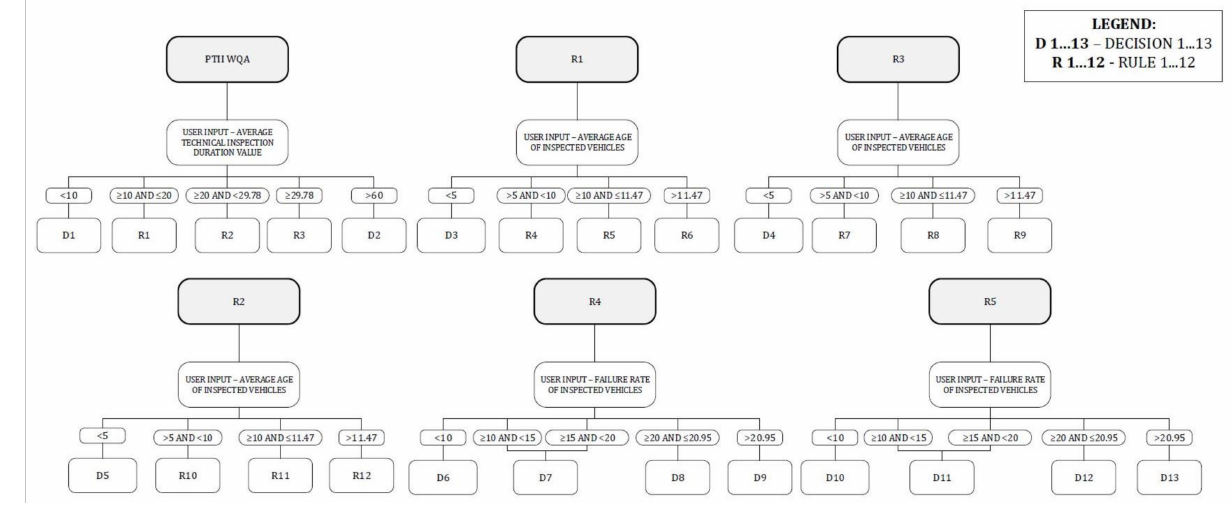
Figure 2. Overview of a part of the knowledge base rules of the PTII WQA